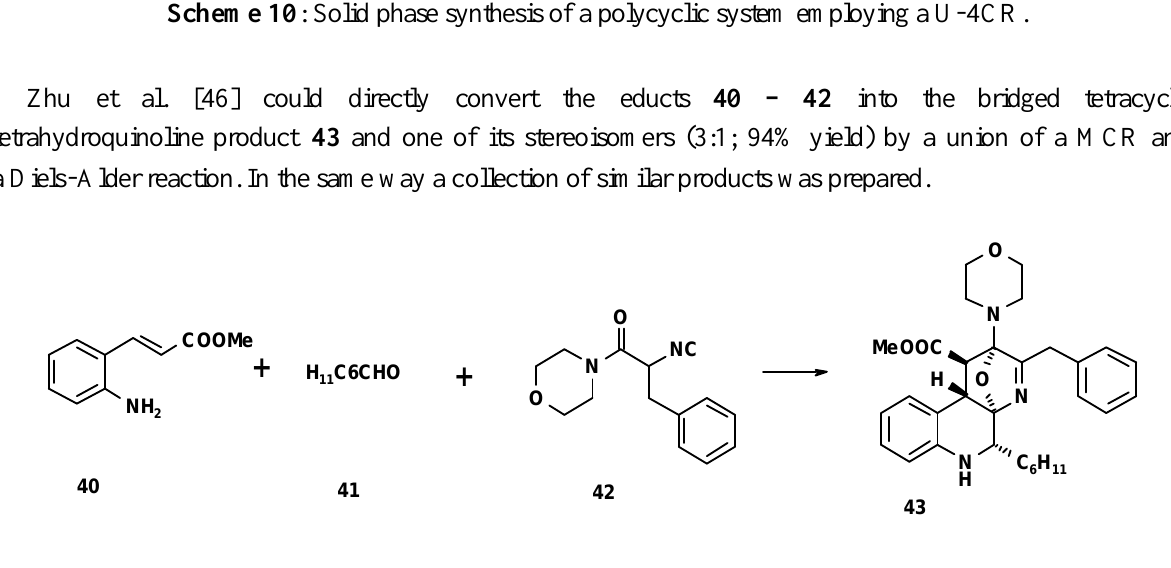
Scheme 11: Three component synthesis of an oxa-bridged tetracyclic